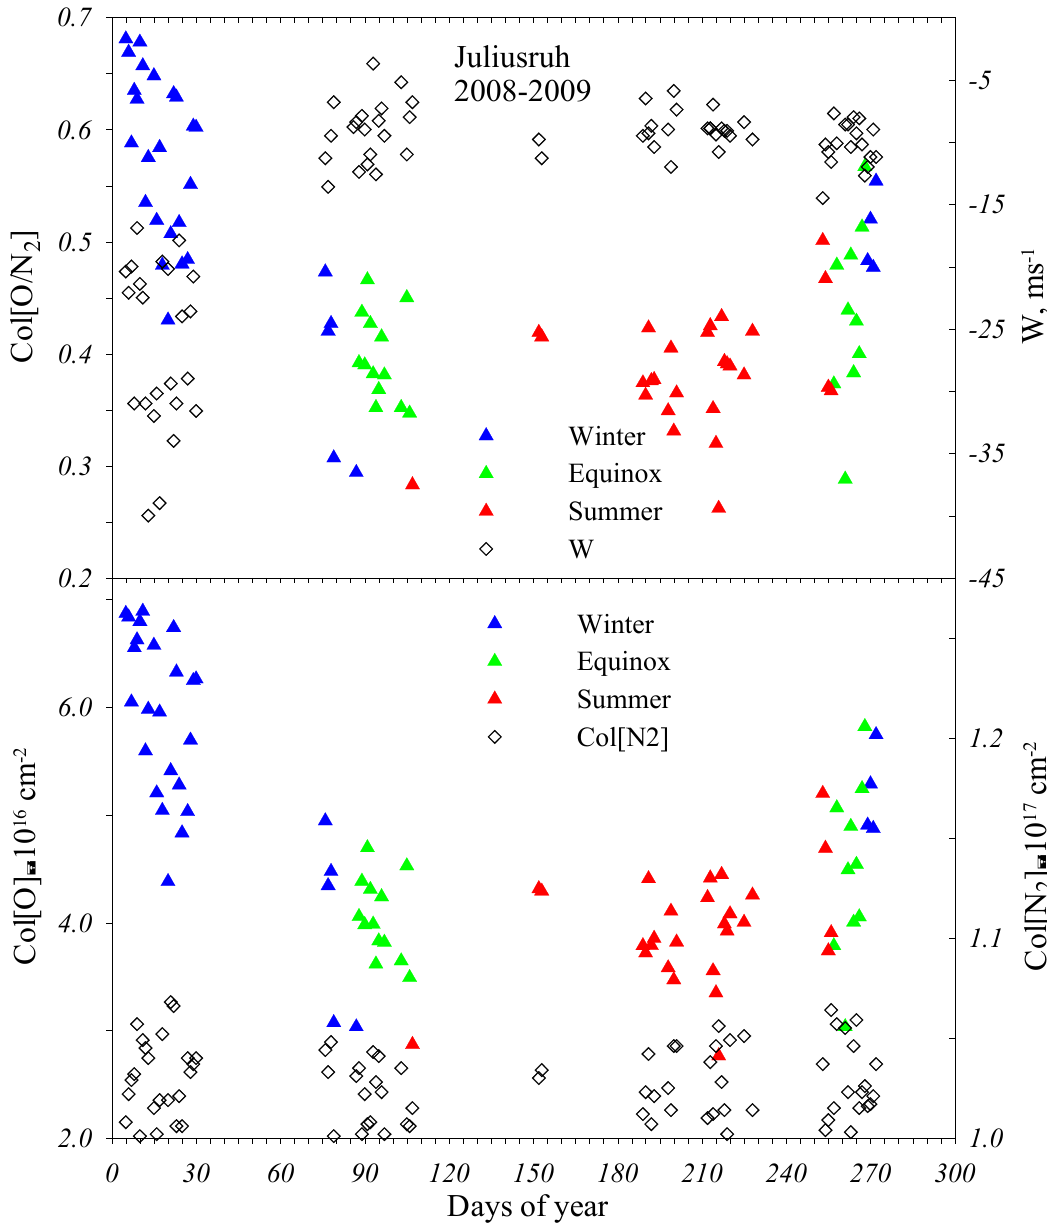
Table 1. Average along with ± SD retrieved at Juliusruh col(O/N 2 ), Tex, and W over the dates with three types of foF 2 diurnal variations.